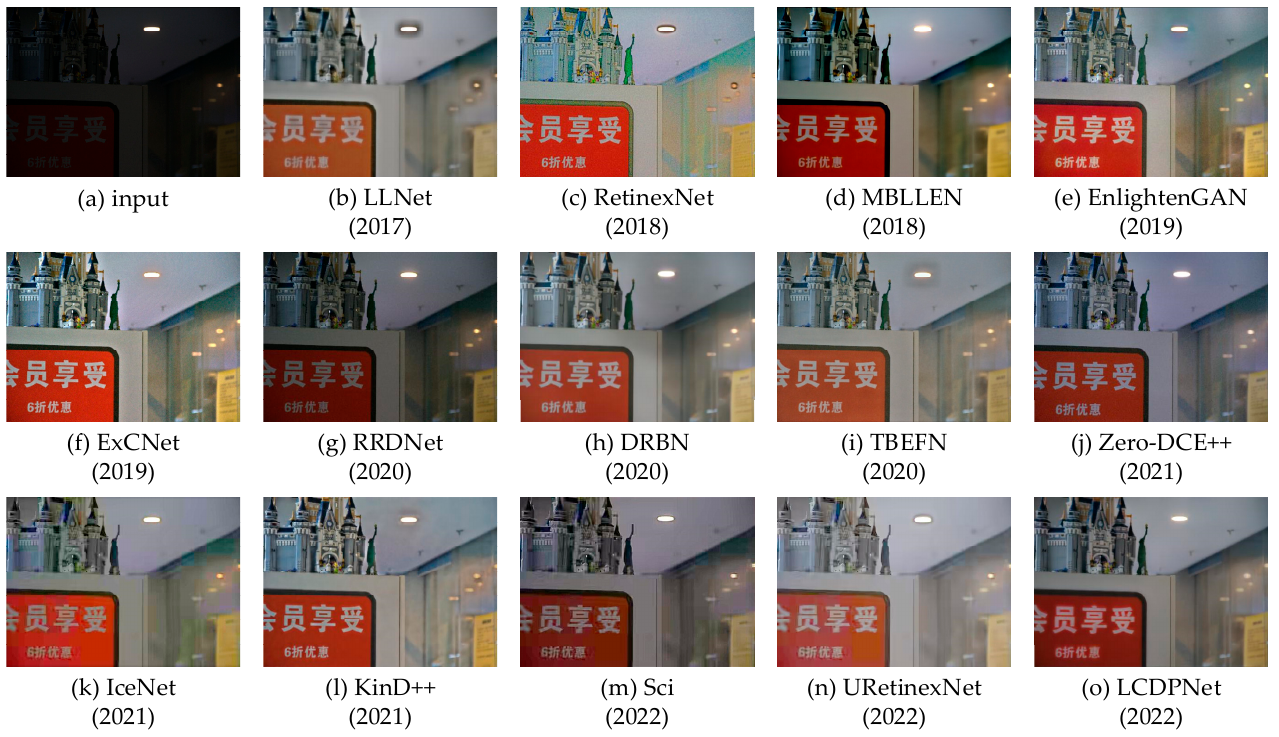
Figure 9. Visual results of different algorithms on low-illumination images sampled from the LOL dataset.